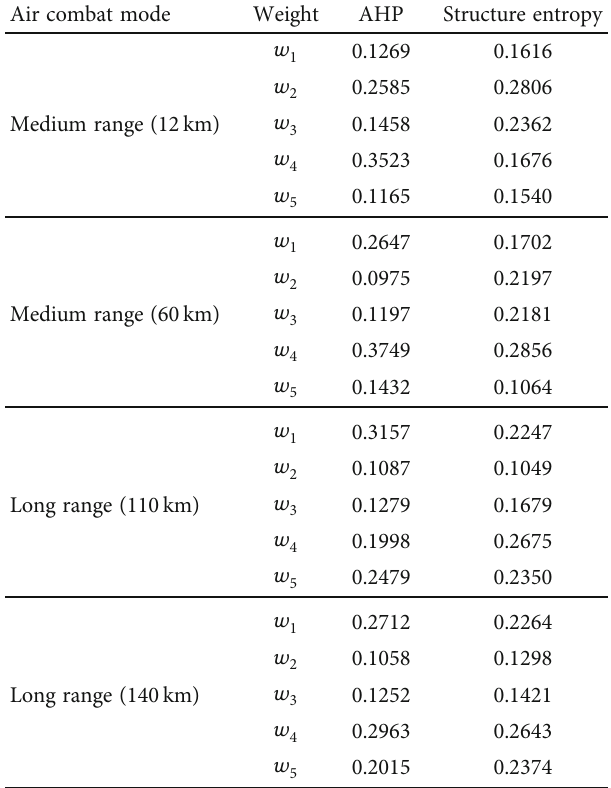
Table 4: Comparison of weights between AHP and structure entropy in di ff erent air combat modes.